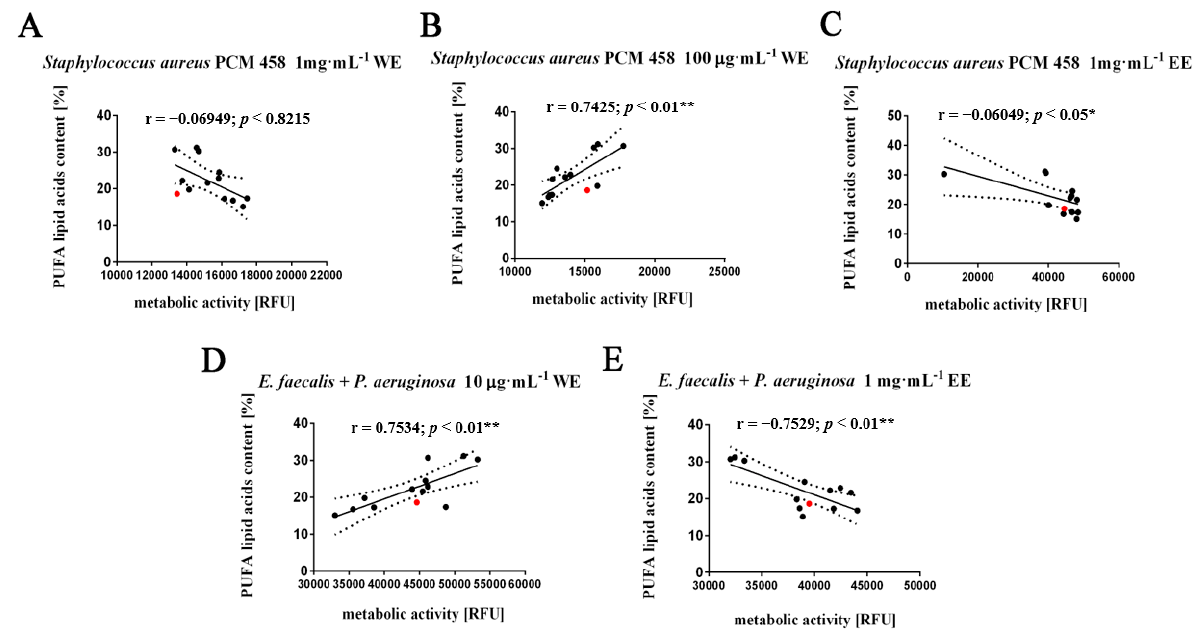
Figure 6. Effect of polyunsaturated fatty acid (PUFA) ( A – E ) on the metabolic activity of selected bacterial species: Staphylococcus aureus PCM 458, mixed two species cultures— Enterococcus faecalis and Pseudomonas aeruginosa . Twelve water or ethanol extracts with defined concentrations of 1 mg·mL − 1 , 100 μ g·mL − 1 , 10 μ g·mL − 1 (black dots) were considered. WT cells are marked with a red dot. Results represent the mean from three independent experiments. The 95% confidence interval is shown. Correlation analysis of the data was performed using a Linear Correlation (Pearson r) test.